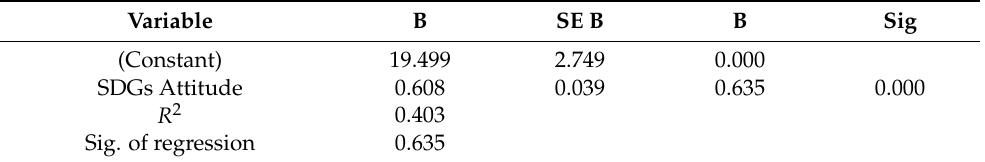
Table 11. Summary of regression analysis for SDGs attitude predicting SDGs